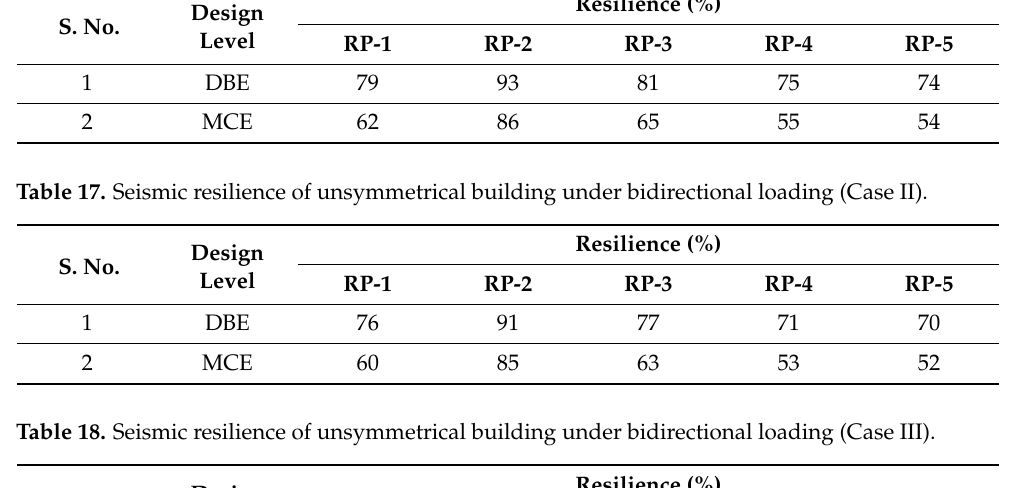
Table 16. Seismic resilience of unsymmetrical building under bidirectional loading (Case I). Design S. No.